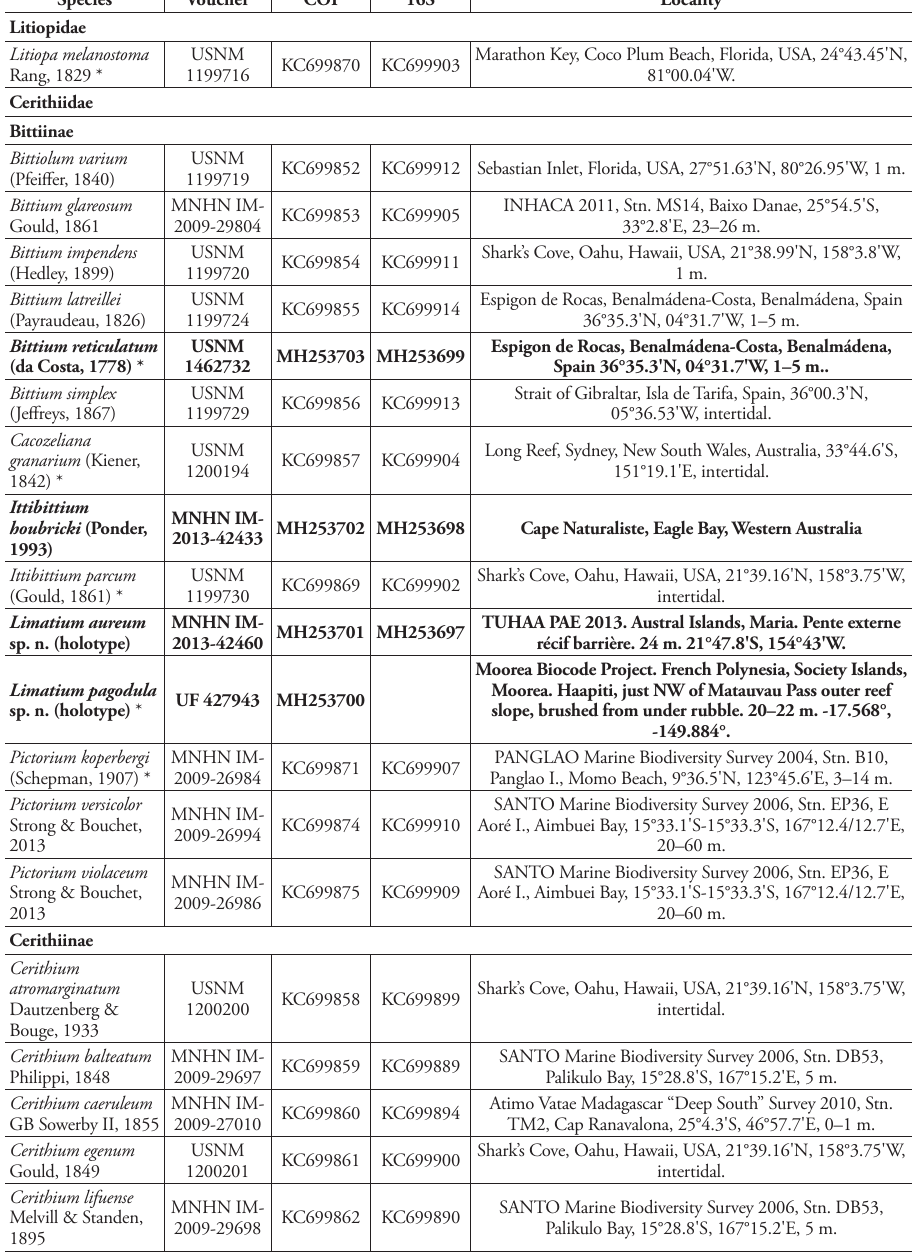
Table 1. Museum registration and GenBank accession numbers for specimens included in the phyloge- netic analysis. Representatives of type species (or their subjective synonyms) of genera currently accepted as valid, indicated by ‘*’. Sequences previously published in the analysis of Strong and Bouchet (2013) in regular font, newly sequenced specimens in